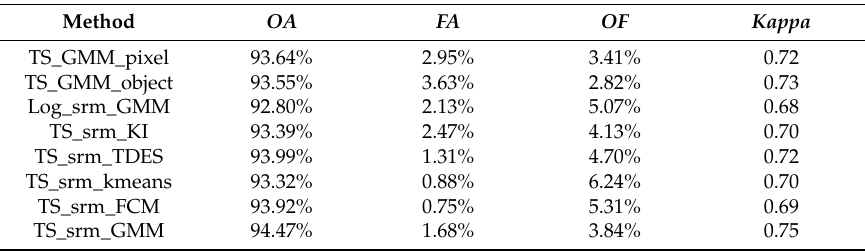
Table 1. Performance evaluation of the change detection over YanDong